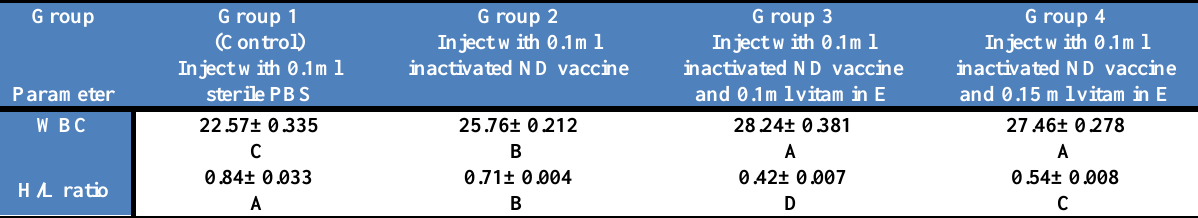
Table, 2: Effect of vitamin E in White Blood Cells (Cell x 10 3 /mm 3 ) and Heterophil /Lymphocyte ratio of Blood for different groups at 35 days old. (Mean ± Standard Error).